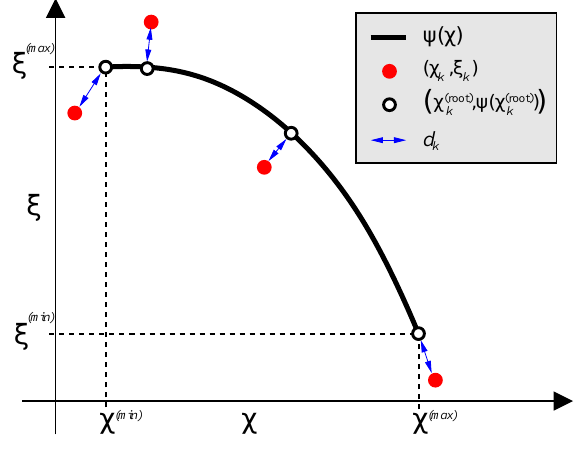
Fig. B1. A schematic of the ‘minimum’ distance function d k (left- right arrows) for different correlation points (χ k ,ξ k ) (filled circles). (χ (ψ) ,ψ(χ (ψ) ) (unfilled circle) is the point on the pre-existing functional curve (thick line) that is nearest, in a normalized sense, to (χ k ,ξ k ) .